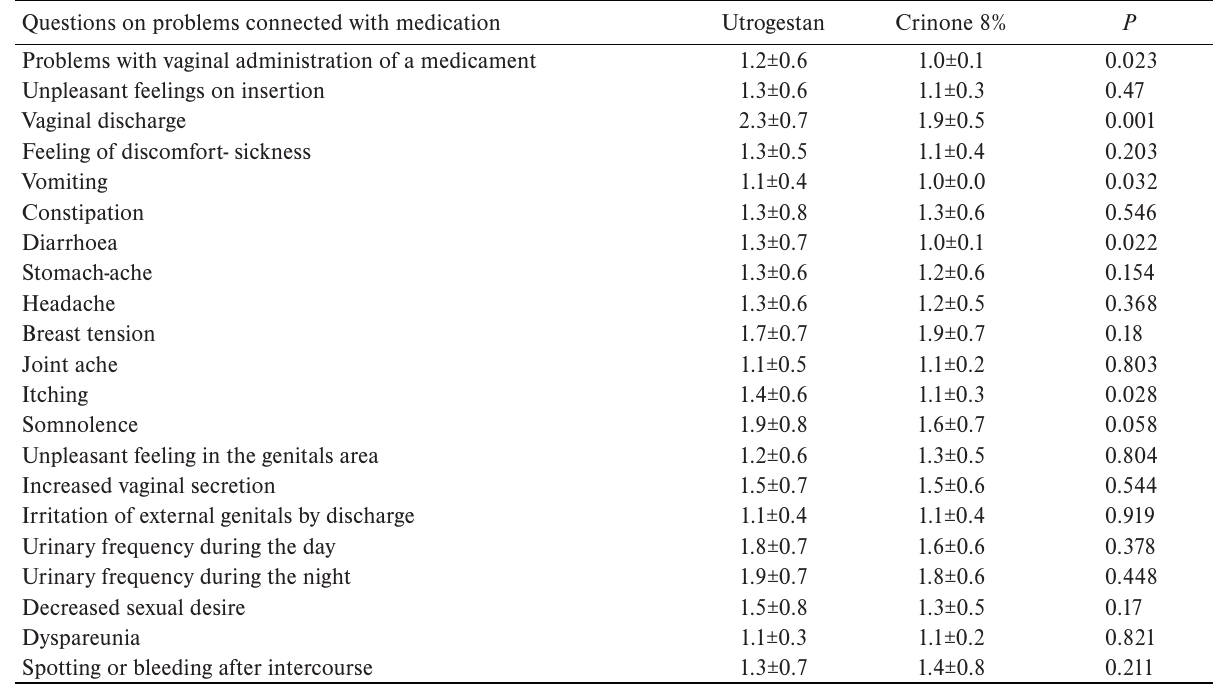
Table 3. Evaluation of tolerance in the group with Utrogestan and in the group with Crinone 8%. Questions on problems connected with